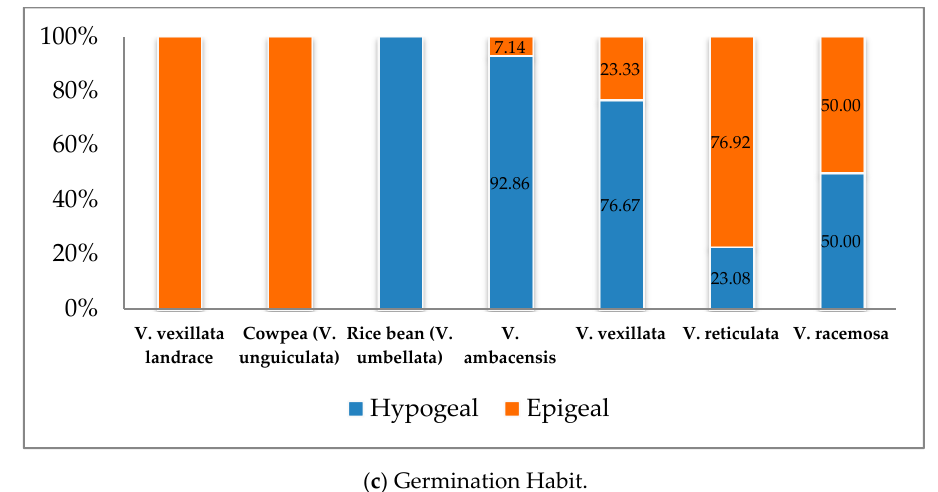
( c ) Germination Habit. Figure 3. Variations of some selected qualitative traits, evaluated at the germination stage. ( a ) hypocotyl color; ( b ) attachment of primary leaves (at the two-leaf stage); ( c ) germination habit.